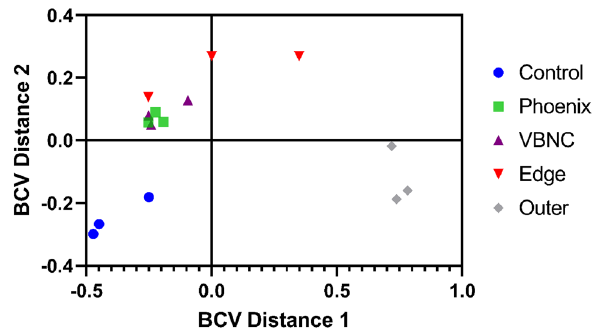
Figure 3. Multi-dimensional scaling (MDS) plot showing clustering of isolates. An MDS plot was generated using biological coefficients of variation (BCV) from transcript counts for each isolate sample. Samples from each group cluster well together aside from the Edge samples, and the phoenix colonies and VBNC-like colonies overlap considerably. Control lawn, Edge, and Outer samples cluster on their own and separately from the Phoenix and VBNC-like samples.